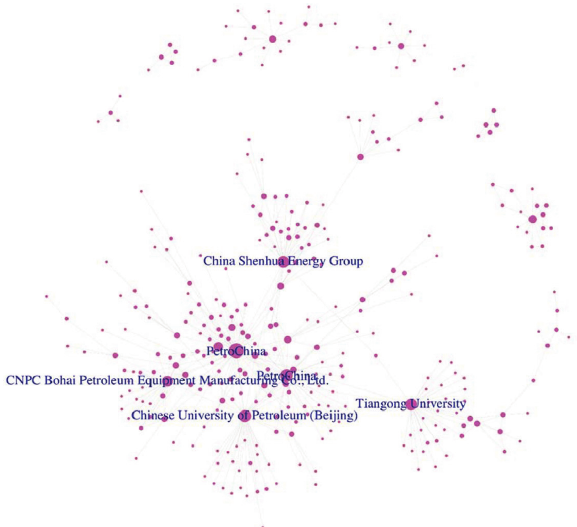
Figure 15: Community in the field of municipal transportation.